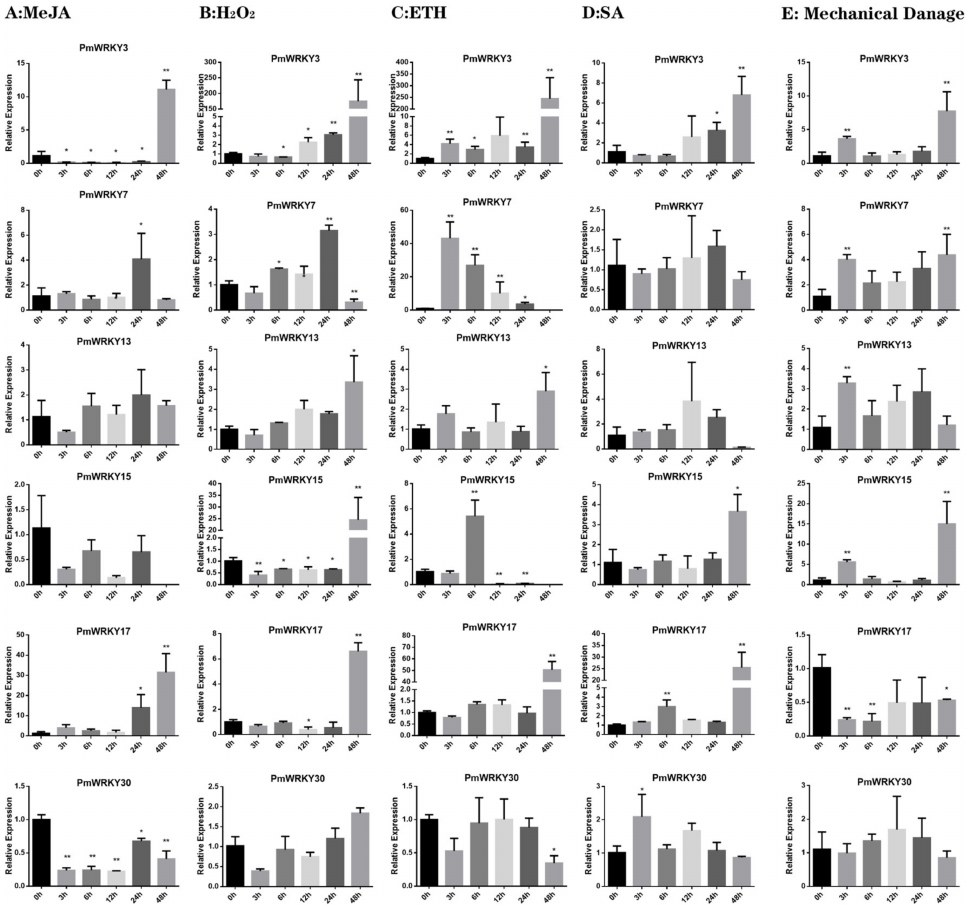
Figure 6. Di ff erential transcription of PmWRKY genes in P. massoniana leaves under abiotic treatments and exogenous hormone supplies. ( A ) MeJA, ( B ) H 2 O 2 , ( C ) ETH, ( D ) SA, ( E ) Mechanical damage stress. The color scale represents relative expression levels based on the values of log 2 (2 − ∆∆ CT ). Asterisks represent significant di ff erences between each time point and 0 h (* p < 0.05, ** p < 0.01). MeJA, methyl jasmonate; H 2 O 2 , hydrogen peroxide; ETH, ethephon; SA, salicylic acid. Color images are available